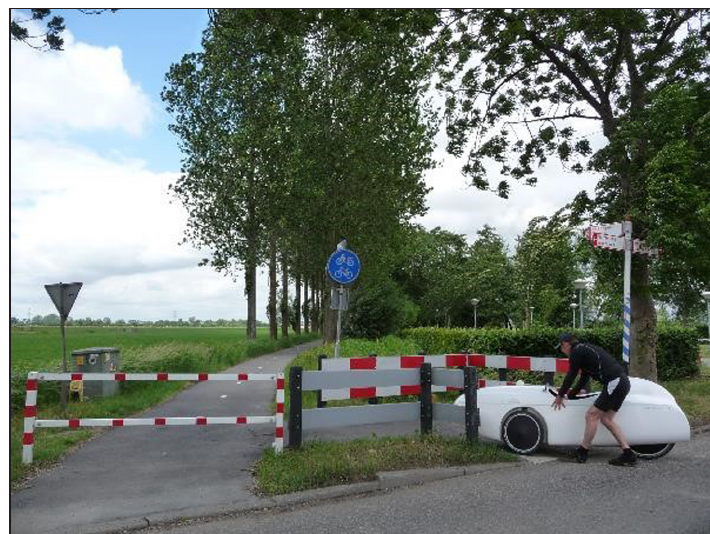
Figure 3: Cycle path blocked for all but “normal”